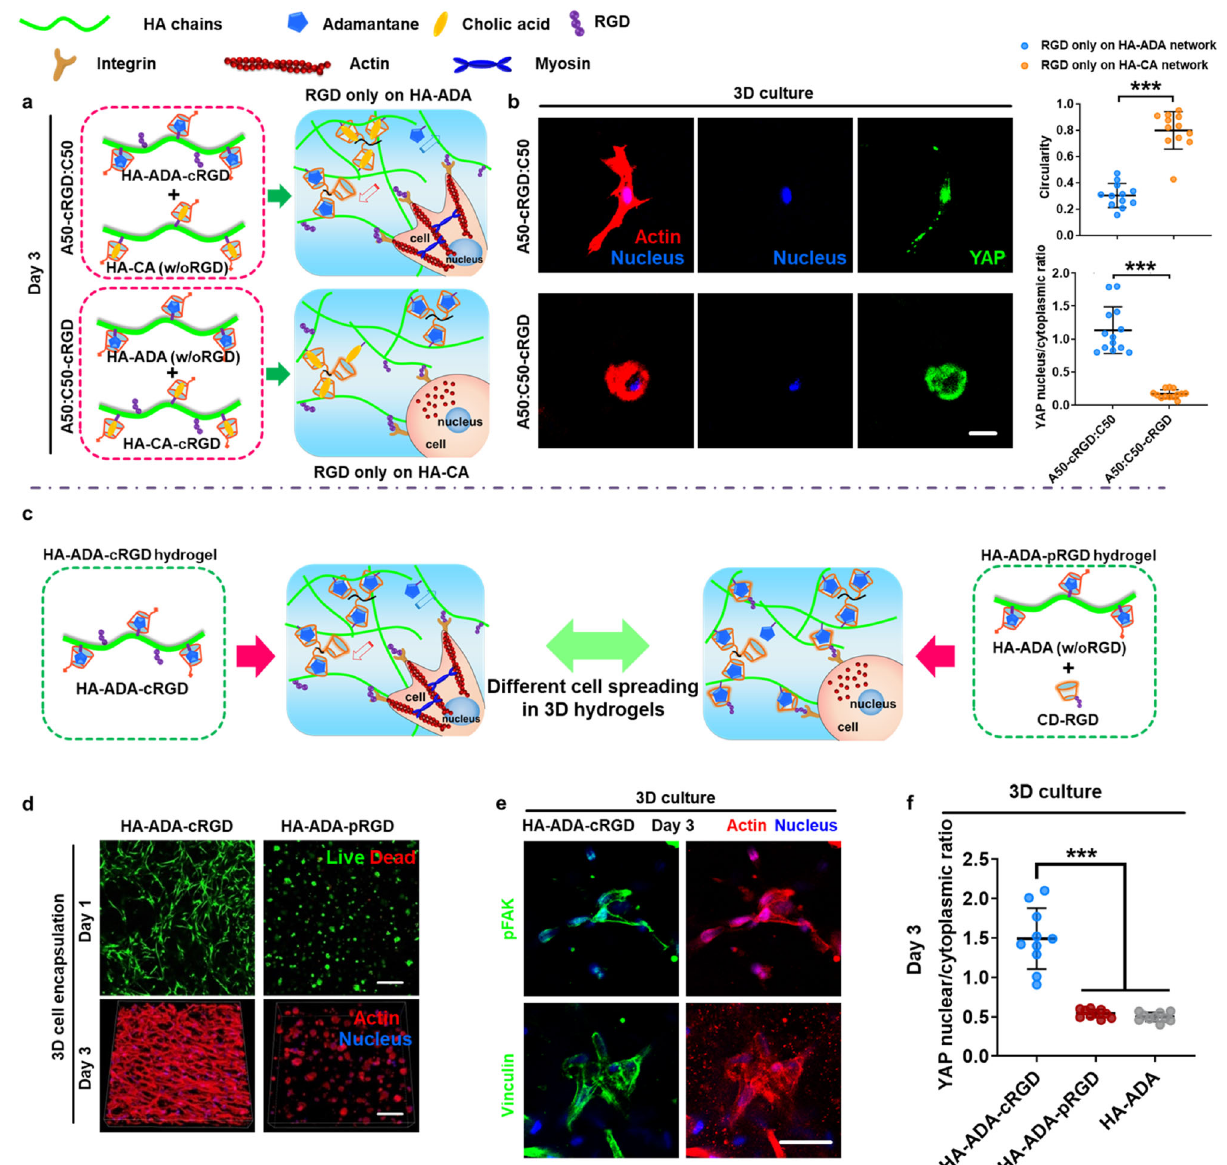
Fig. 4 The precise and covalent conjugation of cell-adhesive ligands to the hydrogel subnetwork connected by crosslinks with fast binding kinetics is required for ef fi cient 3D spreading and mechanosensing of hMSCs. a Schematic illustration of the preparation of A50C50 hydrogels with selective RGD conjugations and 3D cell culture in the hydrogels. RGD peptide was only conjugated either to the HA – ADA subnetwork (A50-cRGD:C50) or to HA – CA subnetwork (A50:C50-cRGD) in the A50C50 hydrogels. b Representative immuno fl uorescence staining against F-actin (red), nuclei (blue), and YAP (green) in hMSCs encapsulated in A50C50 hydrogels with selective RGD conjugations after 3 days of culture (scale bar = 25 μ m) and quanti fi cation of the circularity and nuclear YAP fl uorescence intensity (intensity ratio between the nucleus and cytoplasm). Data are presented as mean values ± SD, n = 12 cells per group from two independent hydrogels; *** p < 0.001 (two-tailed Student ’ s t -test). c Schematic illustration of the preparation of hydrogels with different RGD conjugation methods (HA – ADA – cRGD and HA – ADA – pRGD) and 3D cell culture with different RGD conjugation methods. d Representative images of hMSCs encapsulated within hydrogels (3D cell encapsulation) with different RGD conjugation methods (HA – ADA – cRGD and HA – ADA – pRGD) after 1 and 3 days of culture. Scale bar = 200 µ m. e Representative immuno fl uorescence staining against F-actin (red), nuclei (blue) and pFAK or vinculin (green) in hMSCs cultured in highly dynamic HA – ADA – cRGD hydrogels for 3 days. Scale bar = 50 μ m. f Quanti fi cation of the nuclear YAP fl uorescence intensity (intensity ratio between the nucleus and cytoplasm) in hMSCs encapsulated in hydrogels with different RGD conjugation methods (HA – ADA – cRGD, HA – ADA – pRGD, and HA – ADA) on after 3 days of culture. Data are presented as mean values ± SD, n = 10 cells per group from